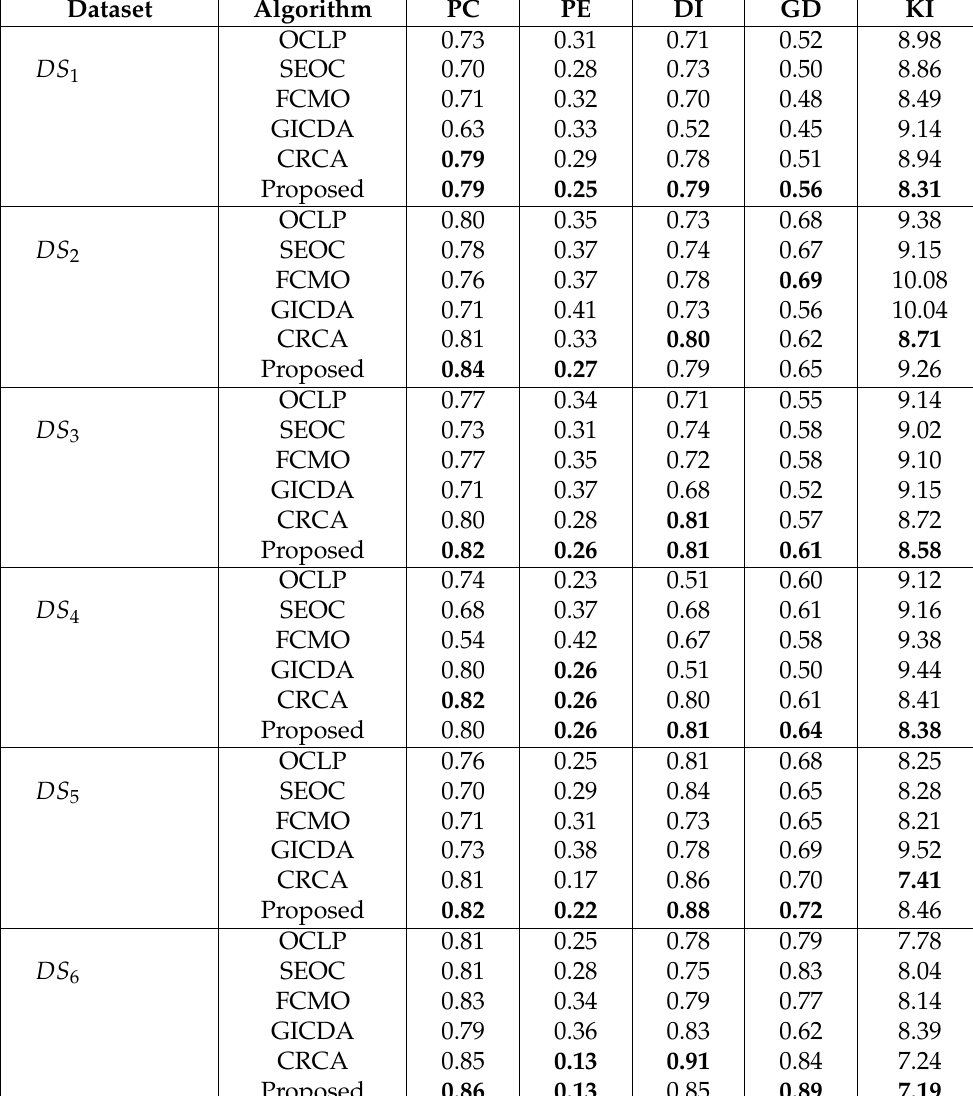
Table 4. Comparison of several clustering techniques using overlapping